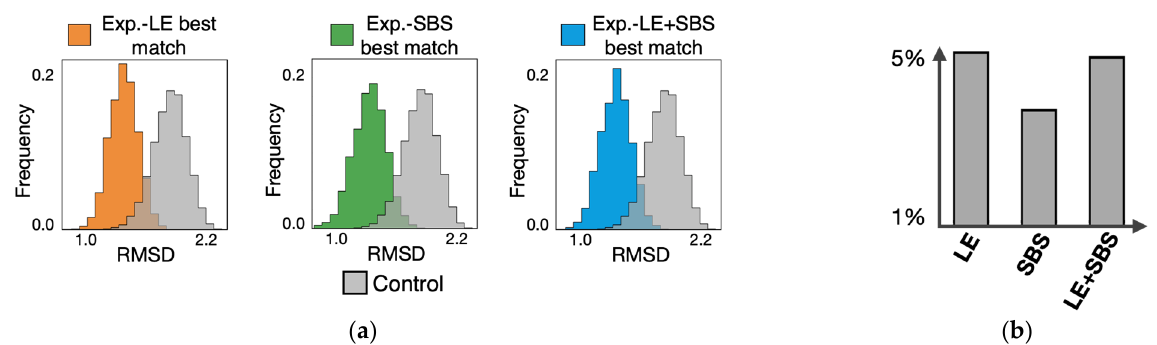
Figure 4. Statistical significance of the RMSD analysis: ( a ) the RMSD distribution of the experiment- model best-matches (for each type of model) is statistically distinguishable from a control made of random pairs of imaged conformations; ( b ) less than 5% of the entries of the experiment-model best-match distributions are within the first 10% of the control. Adapted from [28].